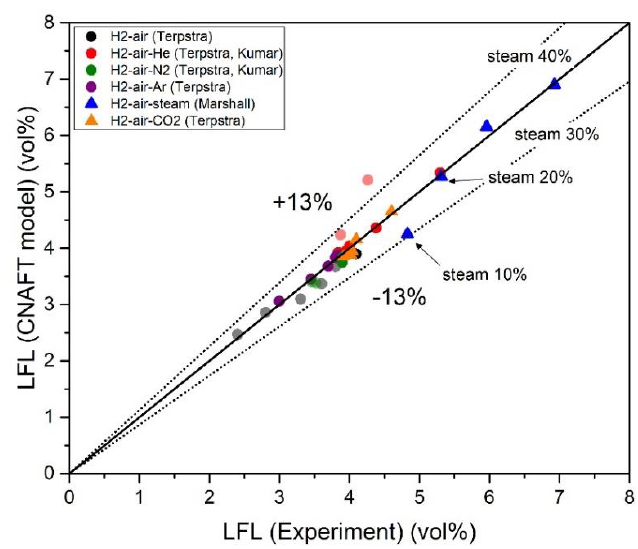
Figure 21. Validation of CNAFT model for various mixtures. The maximum relative error was analyzed as 13%. Reproduced from Ref. [11], Korean Nuclear Society: 2019.